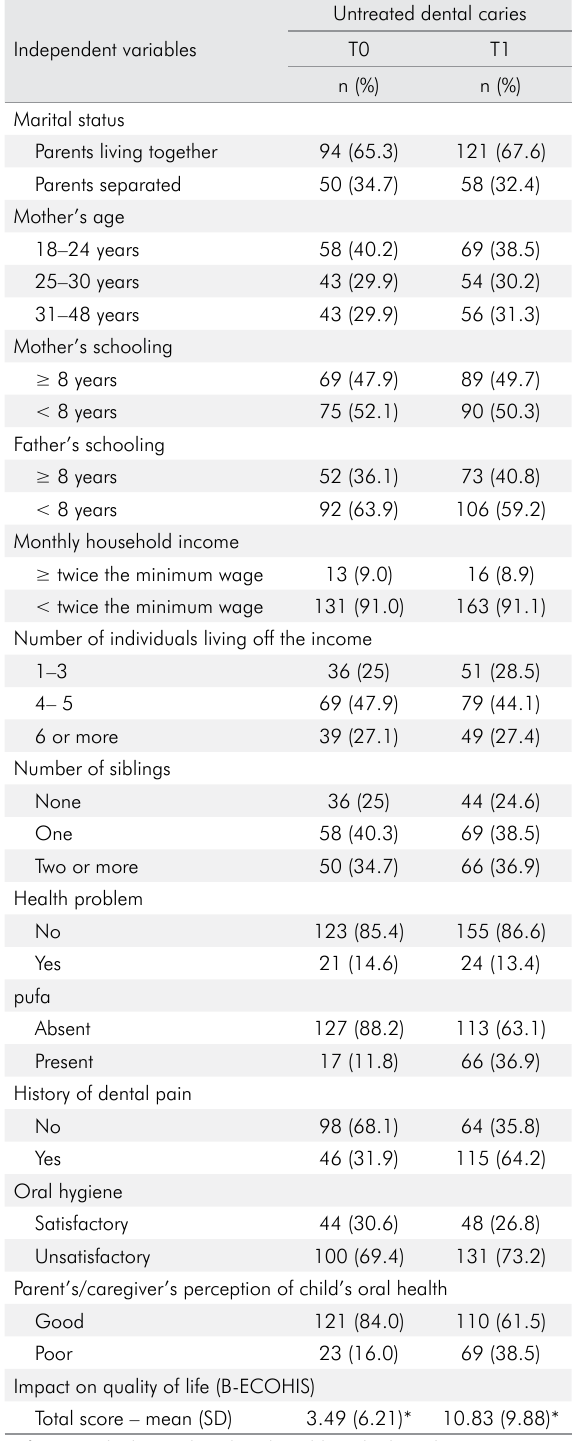
Table 2. Frequency distribution of untreated dental caries in preschool children (n = 288) according to independent variables at baseline (T0) and second examination